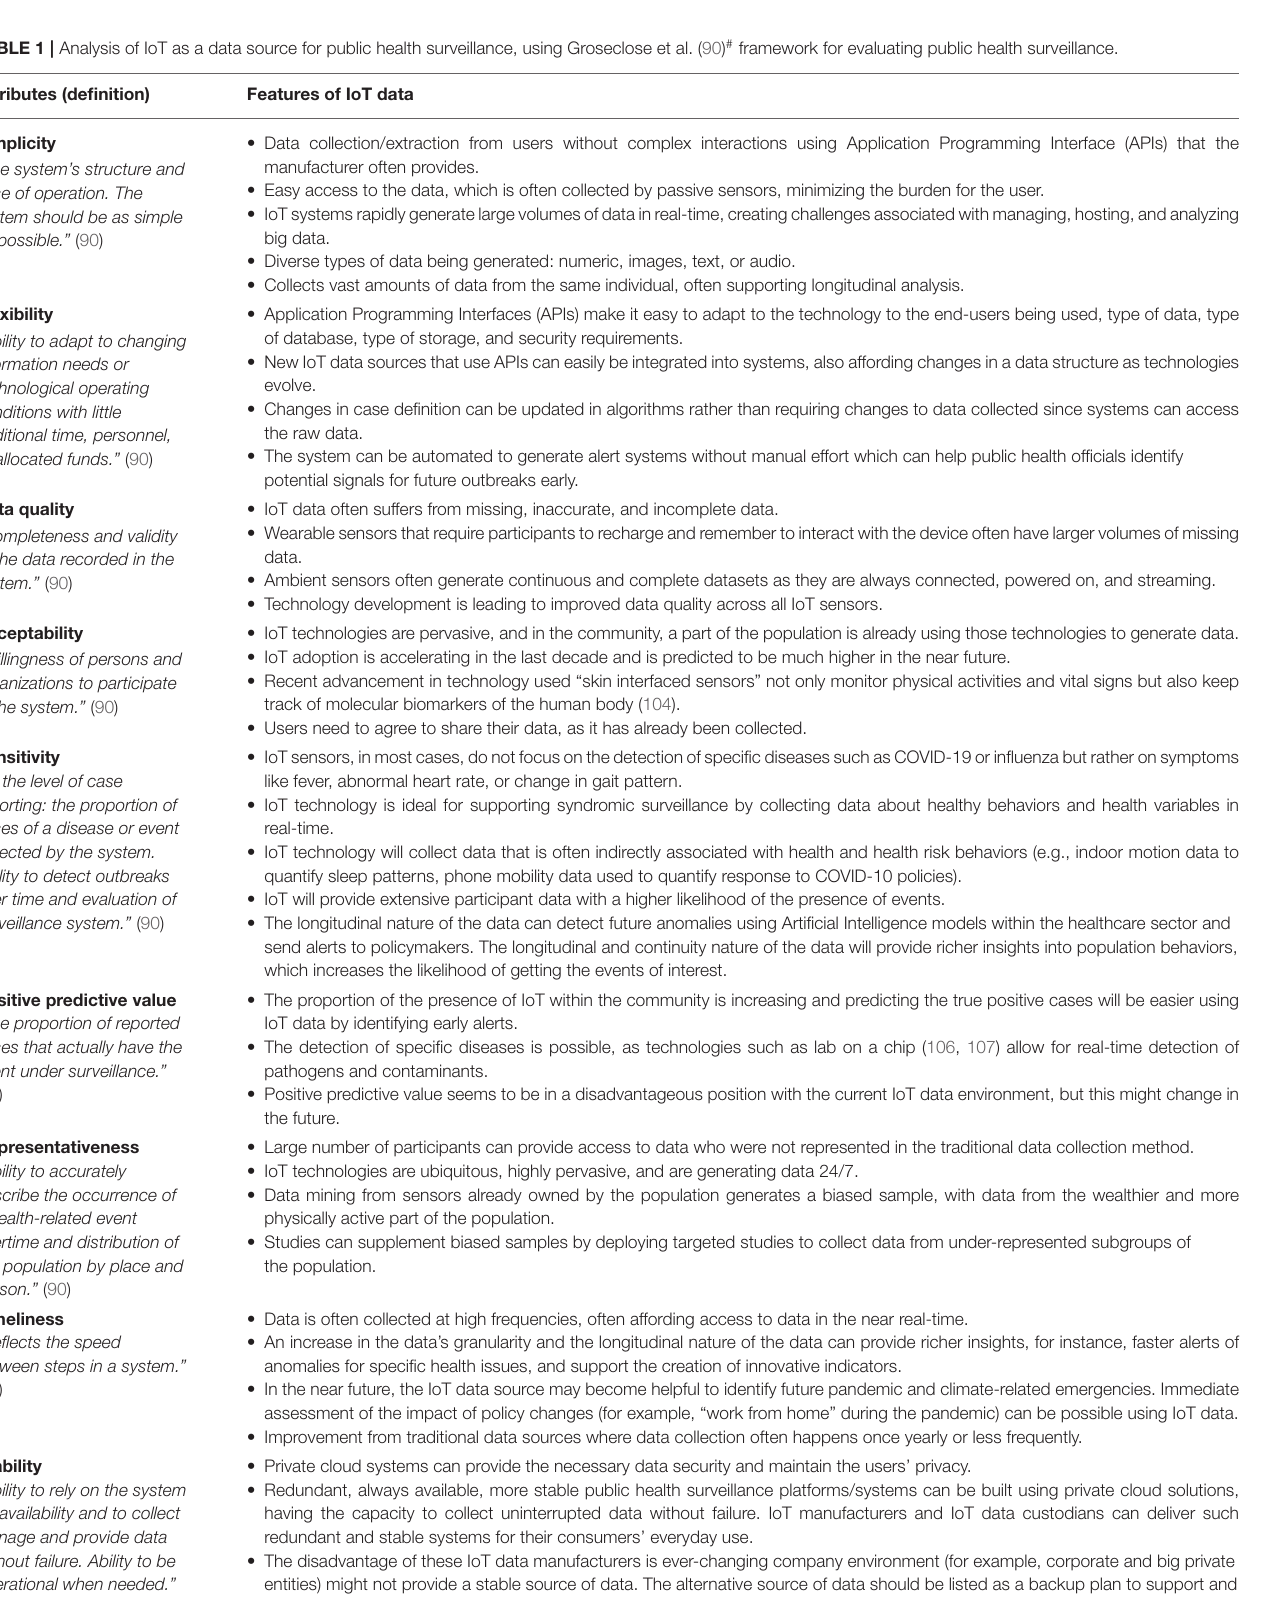
TABLE 1 | Analysis of IoT as a data source for public health surveillance, using Groseclose et al. (90) # framework for evaluating public health surveillance. Attributes (definition) Features of IoT